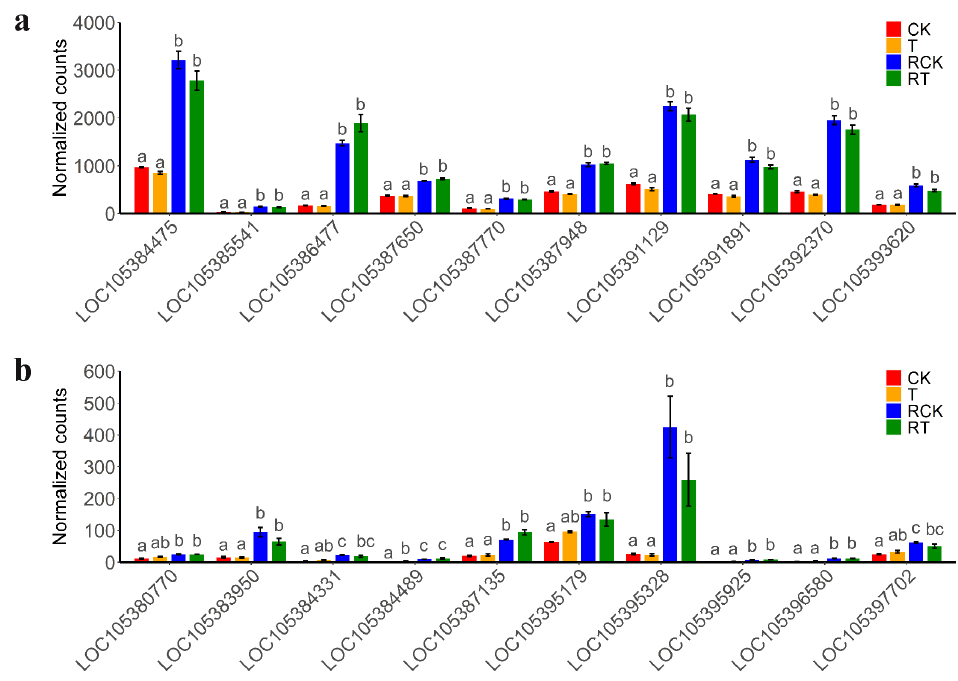
Figure 7. The expression pattern of hub genes in “magenta” ( a ) and “darkred” ( b ) modules. Bars with different colors indicated different strains and insecticide-treatment (shown in Table 2). Values sharing the different letters are significantly different at P < 0.05 (one-way ANOVA followed by Duncan's multiple comparison tests, P < 0.05). LOC105392370: Pyrroline-5-carboxylate reductase; LOC105391891: Adenylosuccinate lyase; LOC105387948: Probable methylcrotonoyl-CoA carboxylase beta chain, mitochondrial; LOC105385541: Uncharacterized; LOC105384475: Trifunction- al purine biosynthetic protein adenosine-3; LOC105391129: Trifunctional purine biosynthetic pro-